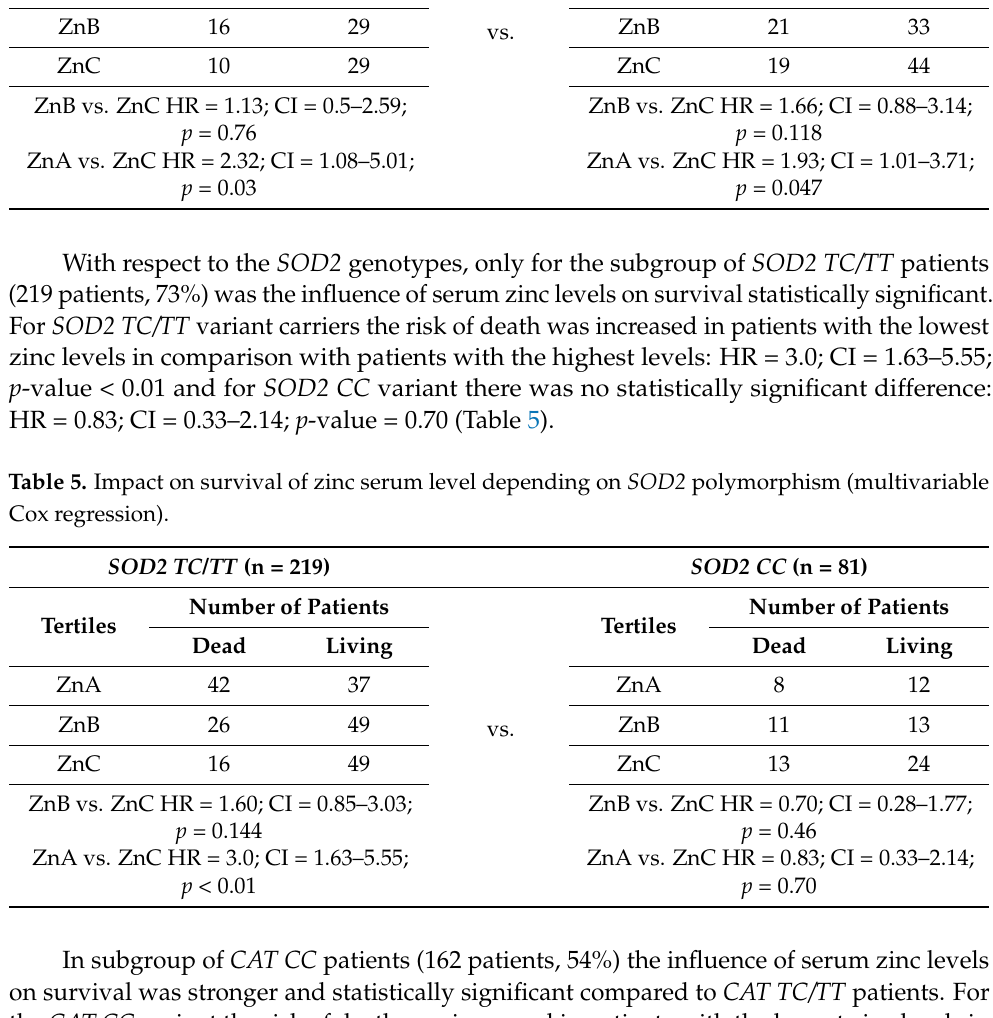
Table 4. Impact on survival of zinc serum level depending on GPX1 polymorphism (multivariable Cox regression). GPX1 TC/TT (n = 128) GPX1 CC (n = 172) Number of Patients Number of Patients Tertiles Tertiles Dead Living Dead Living ZnA 28 16 ZnA 22 33 ZnB 16 29 ZnB vs. ZnC 44